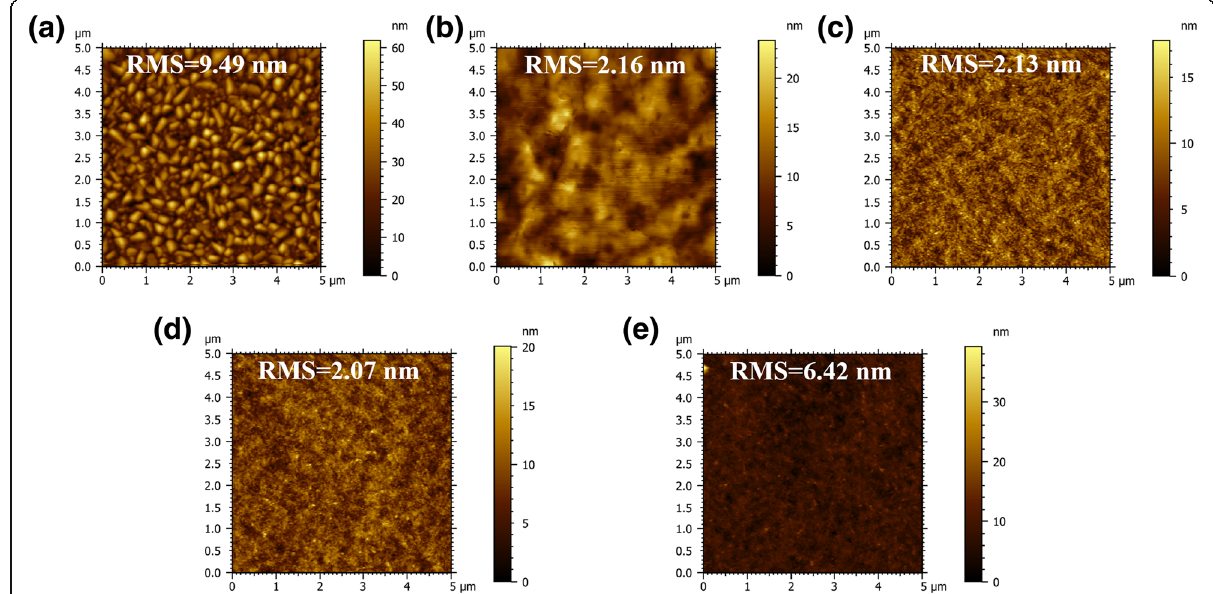
Fig. 3 b AFM topographies of corresponding perovskite films with a 3D perovskite and quasi-2D perovskite based on PPA:Cs cations of b 2:2, c 2:3, d 2:3.5, and e 2:4